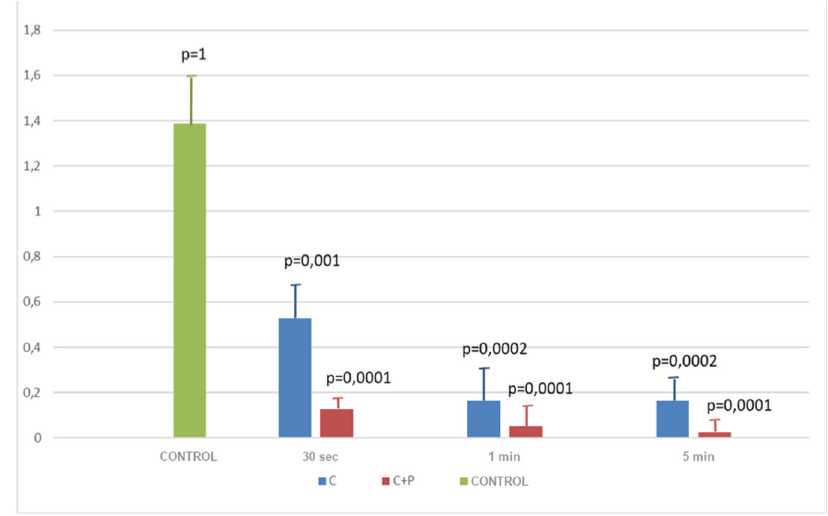
Figure 2. Efficacy of treatments on rough samples. Abbreviations: C = chlorhexidine; C + P = chlorhexidine + air polishing.